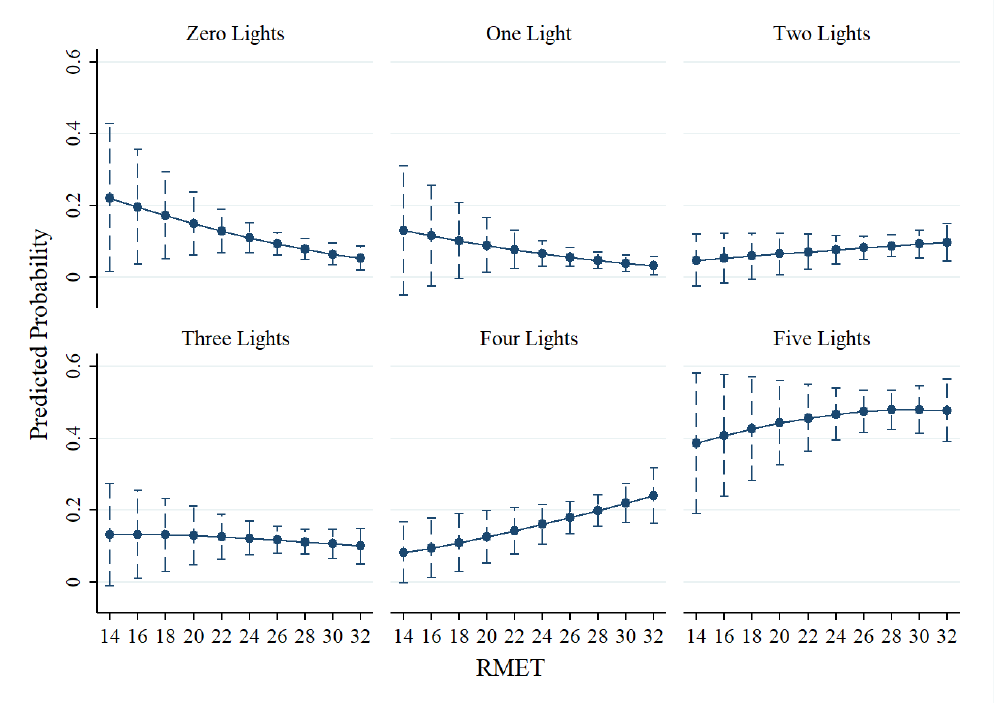
Figure 6. Predicted probability of number of lights by RMET score with 95% confidence intervals. Note: This figure uses the multinomial logit regression results from Table A6. Dashed lines indicate 95% Confidence